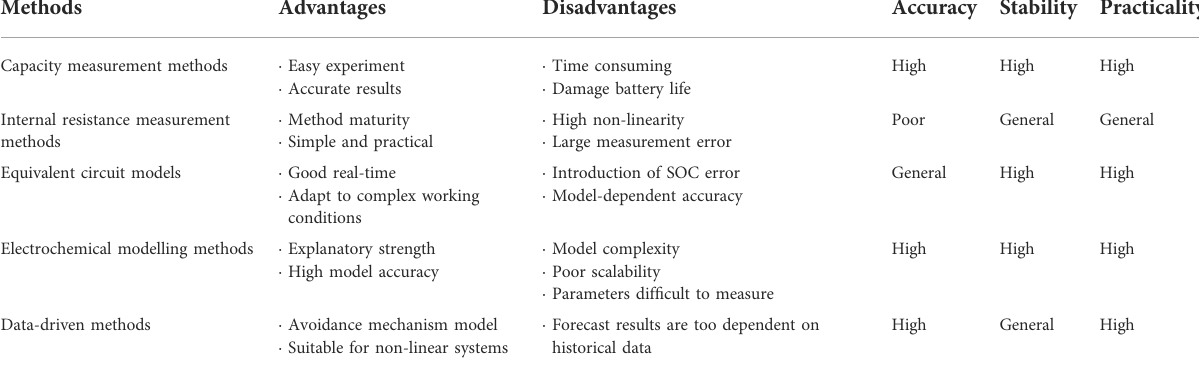
TABLE 2 Evaluation indicators based on joint model estimation